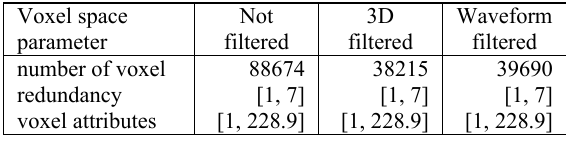
Table 5. Parameters of voxel space before and after filtering